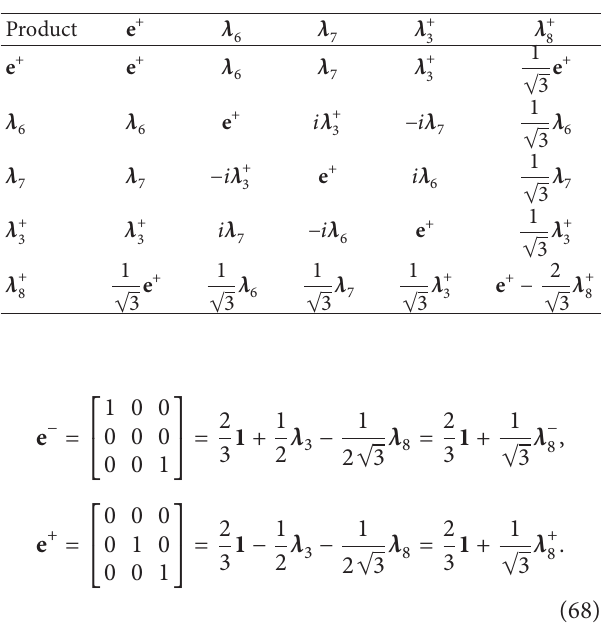
Table 4: Multiplication table of Gell-Mann matrices { 𝜆 6 , 𝜆 7 , 𝜆 + 3 , 𝜆 + 8 } (left times